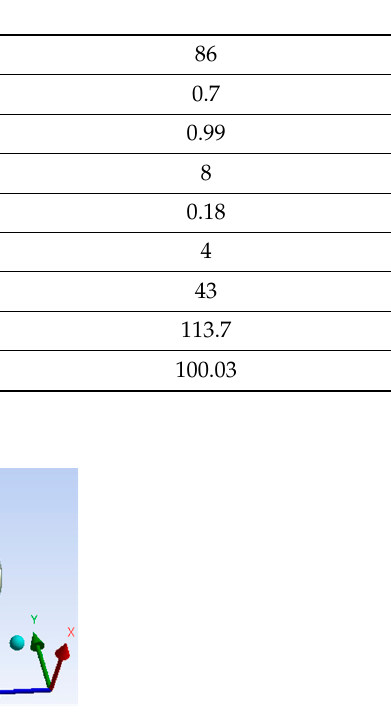
Figure 10. Geometrical model of the underwater robot. ( a ) Planform; ( b ) Cubic diagram